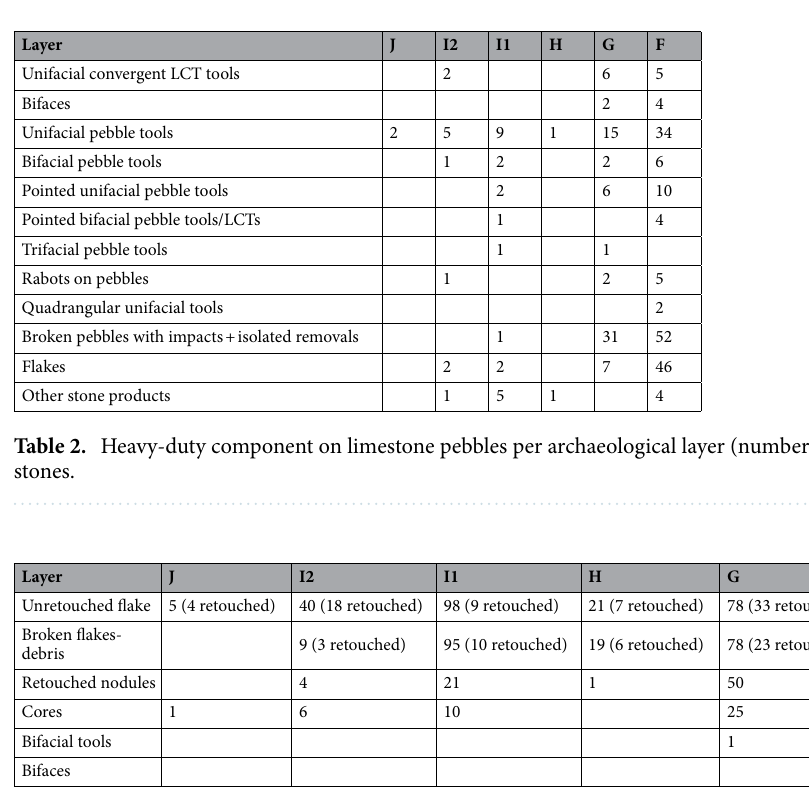
Table 3. The tool kit on chert: number of flakes, fragments of flakes, retouched nodules and heavy-duty tools per archaeological layer.